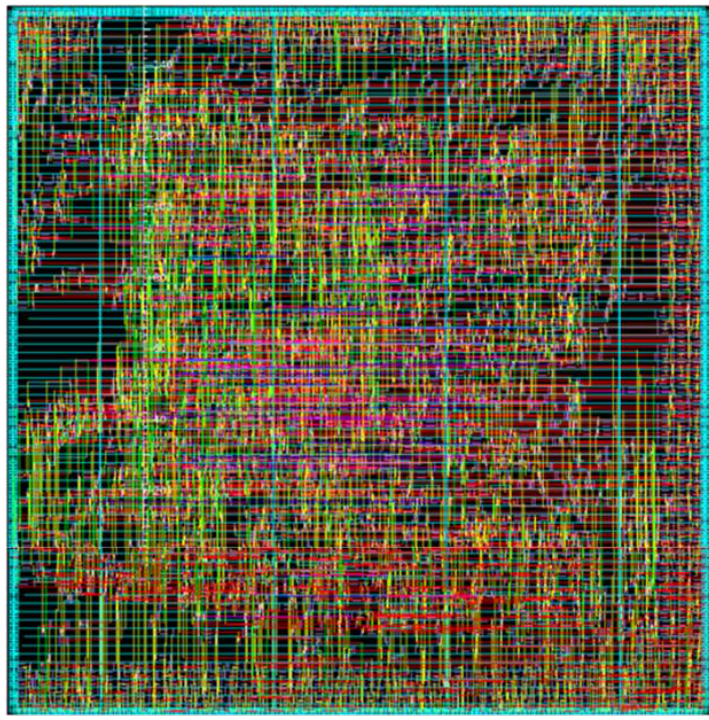
Figure 20. Picture of the implemented ME module in 65